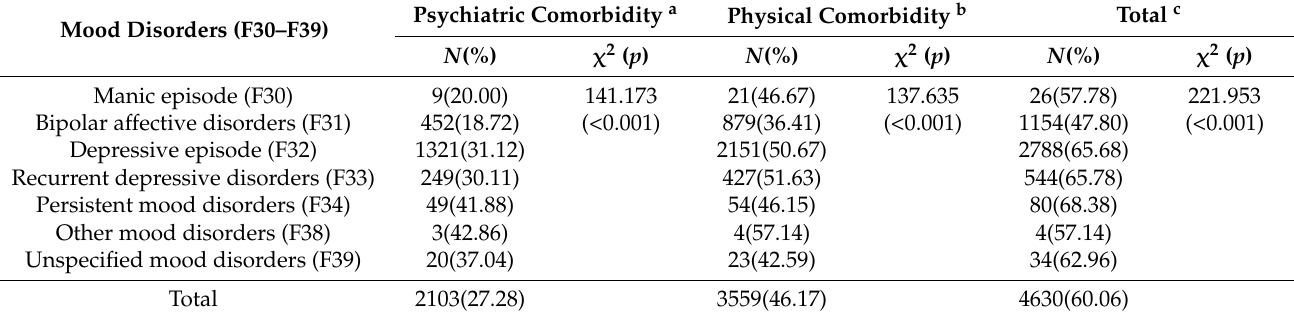
Table 2. Prevalence of comorbid diseases by sub-diagnosis of mood